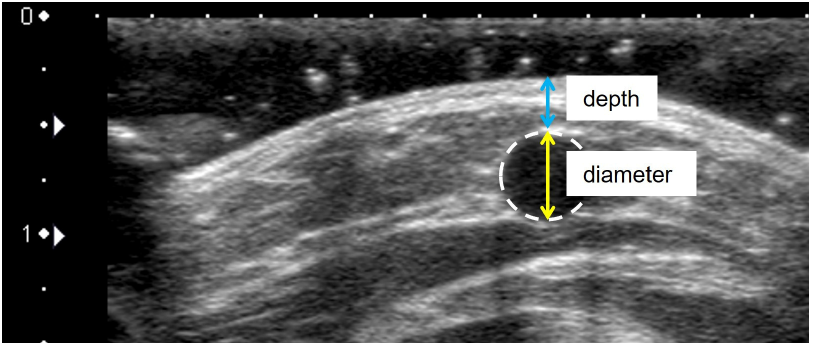
Figure 3. Measurement of venous diameter and depth by ultrasonography. Notes: Venous diameter (mm) was measured from the upper end to the lower end of the vein. Depth (mm) was measured as the vertical distance from the skin surface to the apex of the vein